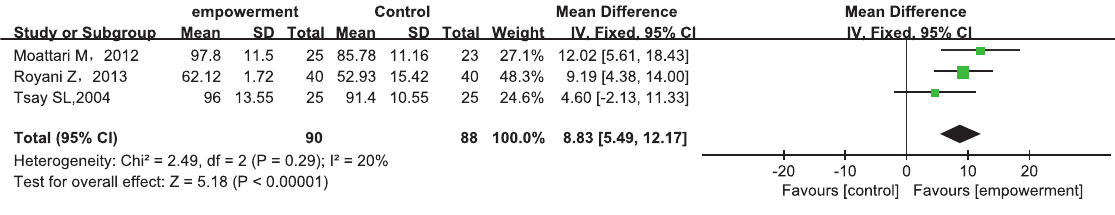
Figure 2. Comparison of 6-week self-efficacy between empowerment education intervention group and traditional education